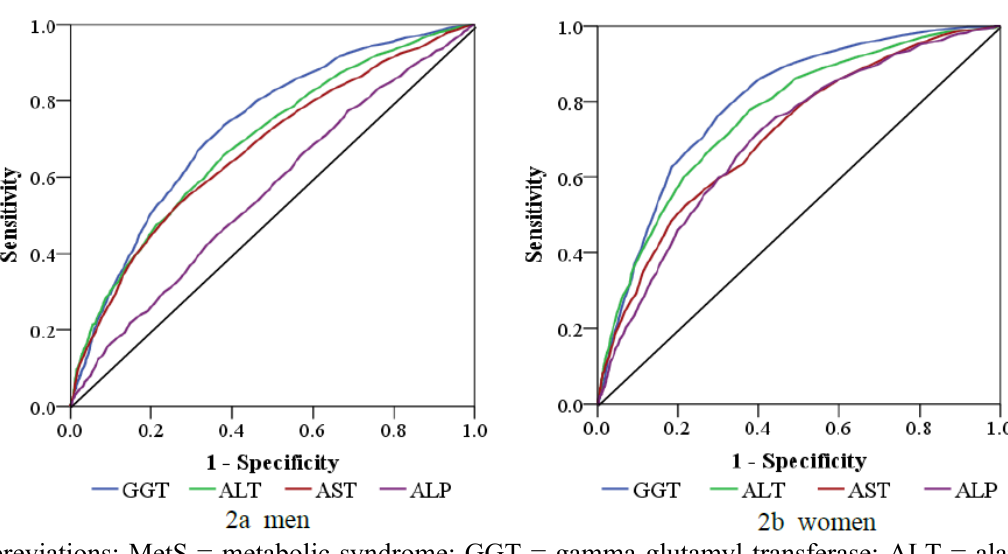
Figure 2. ROC analysis of GGT, ALT, AST, and ALP for the diagnosis of